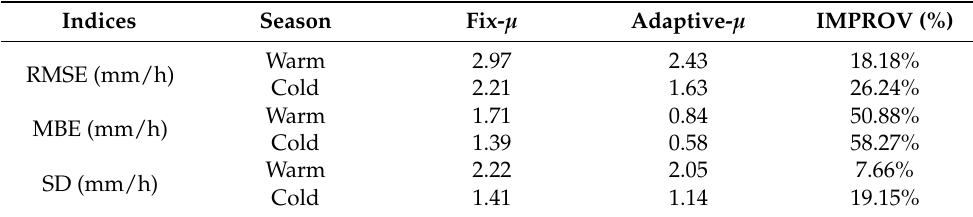
Table 5. Comparison of the fixed- and adaptive- µ model results in terms of RMSE, MBE, and SD indices for different seasons under the Thompson aerosol-aware